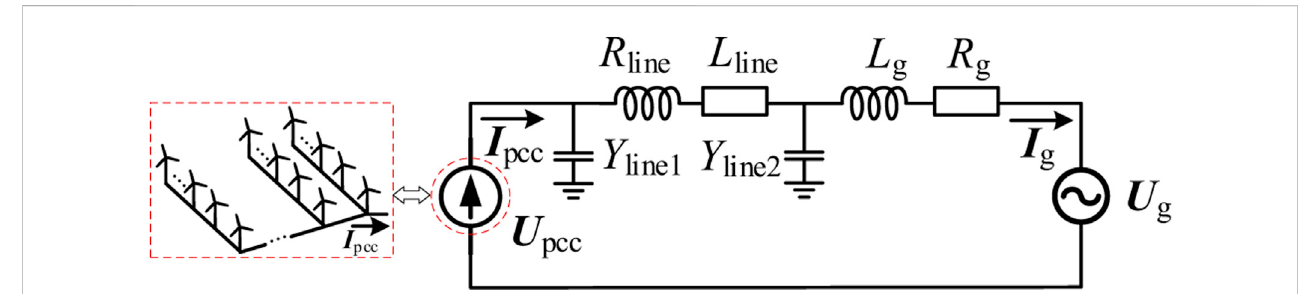
FIGURE 2 Equivalent current of AC side of